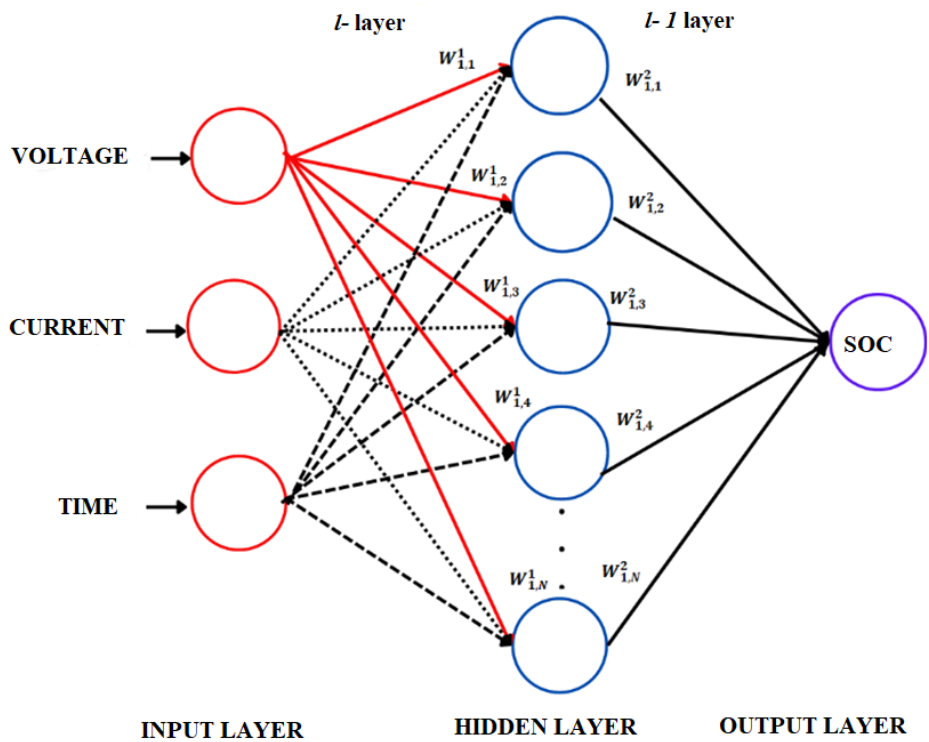
Figure 1. FNN lifetime battery degradation prediction model. The input battery data are detonated by ϕ f = [ T f , I f , V f ] , where T f , I f , and V f represent the time, current and the voltage at time step f . The estimated ϕ o = SOC f is the output of the FNN at each time step f .